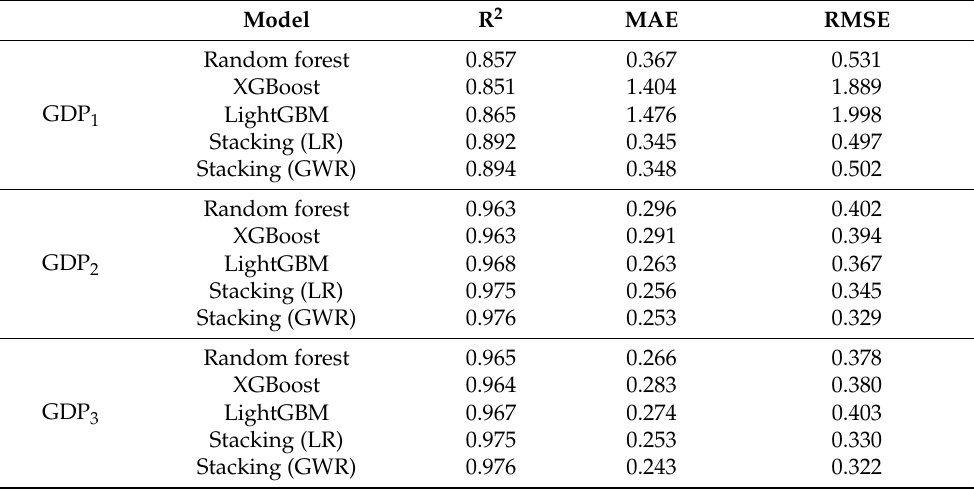
Table 2. Performance comparison of different methods on test